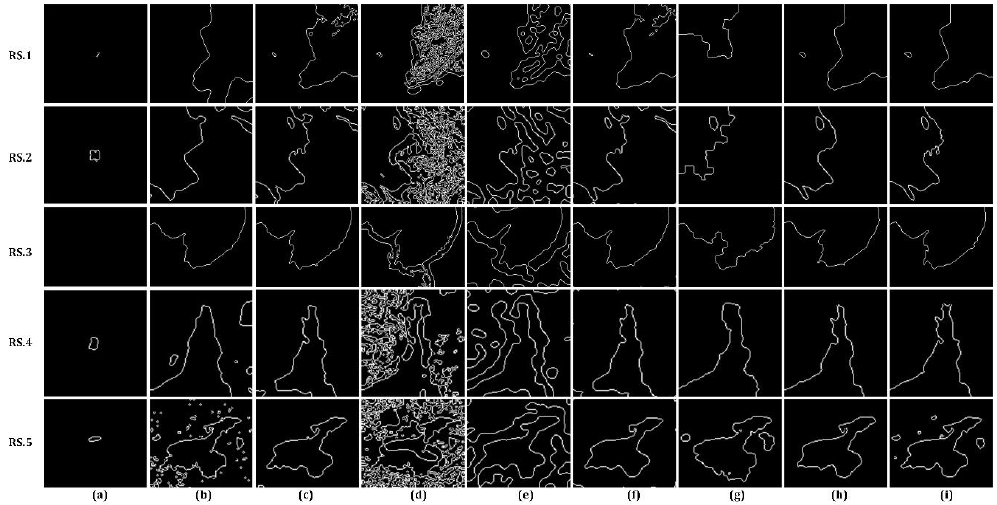
Figure 15. Boundary maps of remote sensing image database: ( a ) GAC; ( b ) CV; ( c ) SBGFRLS; ( d ) LBF; ( e ) ILFE; ( f ) Cao’s model; ( g ) MSRM; ( h ) the proposed method; ( i ) ground truth. Table 3. Statistic for BP values, and bold values indicate the top two results.